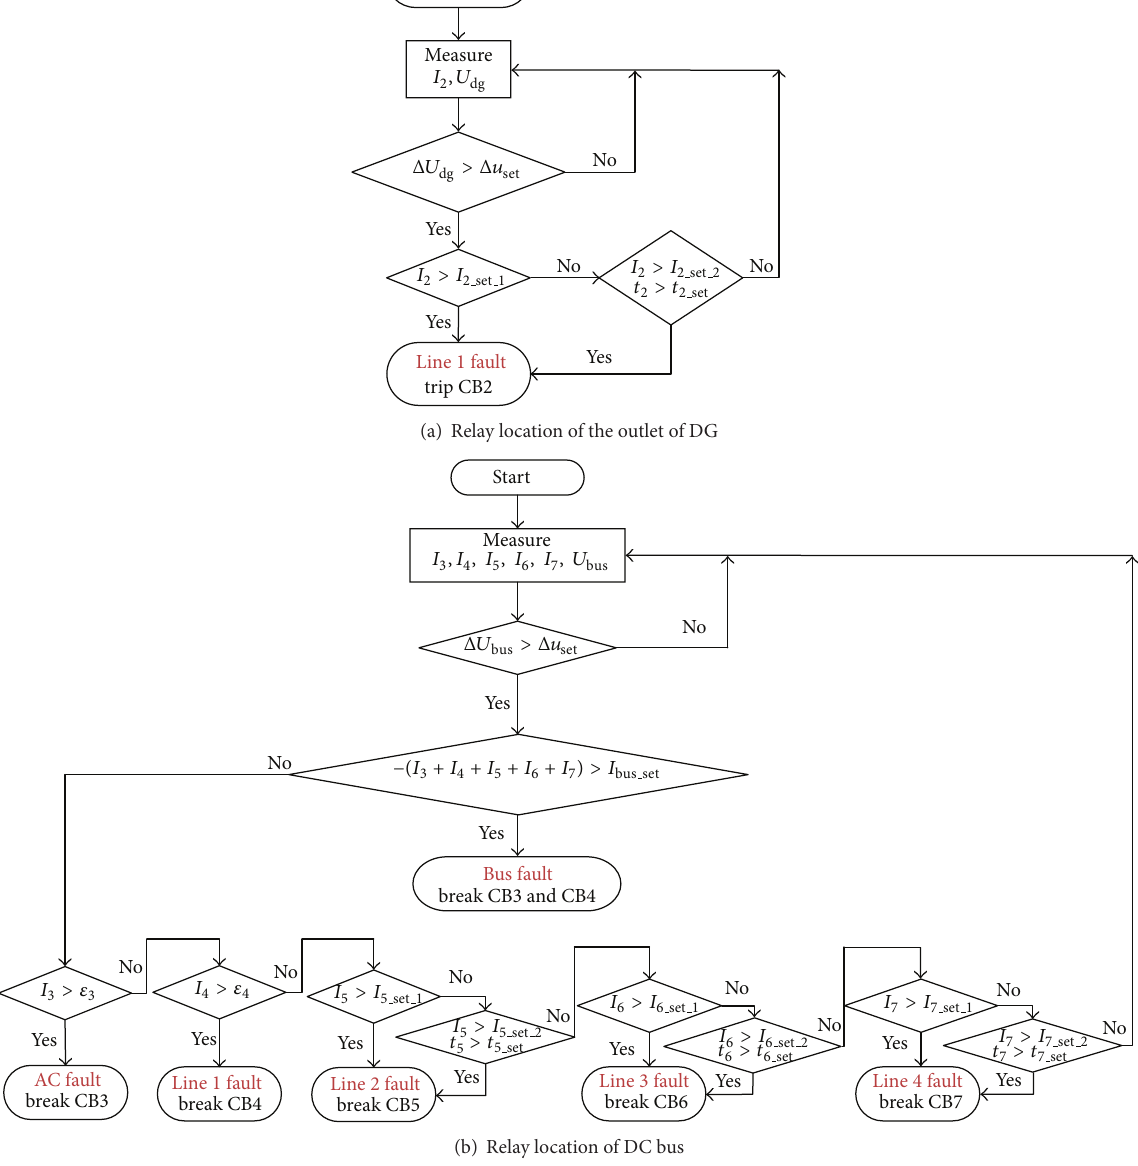
Figure 8: Flow charts of relay